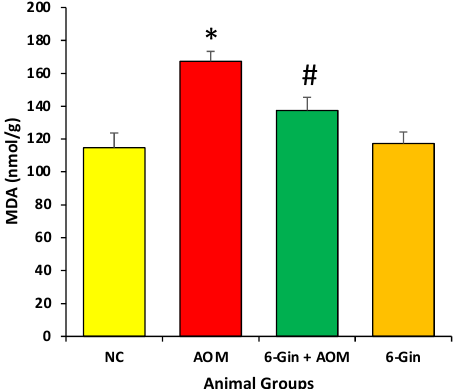
Figure 3. The protective effect of 6-Gingerol on the azoxymethane-induced lipid peroxidation level. Data are represented as ± standard error of mean (SEM). The different groups are NC as normal control, AOM as azoxymethane treatment group (disease control), 6-Gin + AOM as 6-gingerol treatment to disease control and 6-Gin as only 6-gingerol treatment group. The * indicates significant difference ( p < 0.05) between disease control vs. normal control and # indicates significant difference ( p < 0.05) between disease control and disease control with treatment.